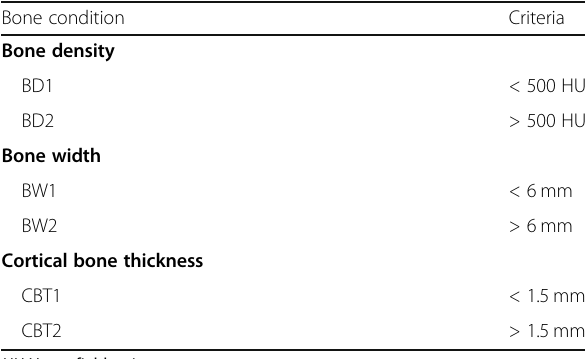
Table 1 Categories of bone condition measured in the implant site